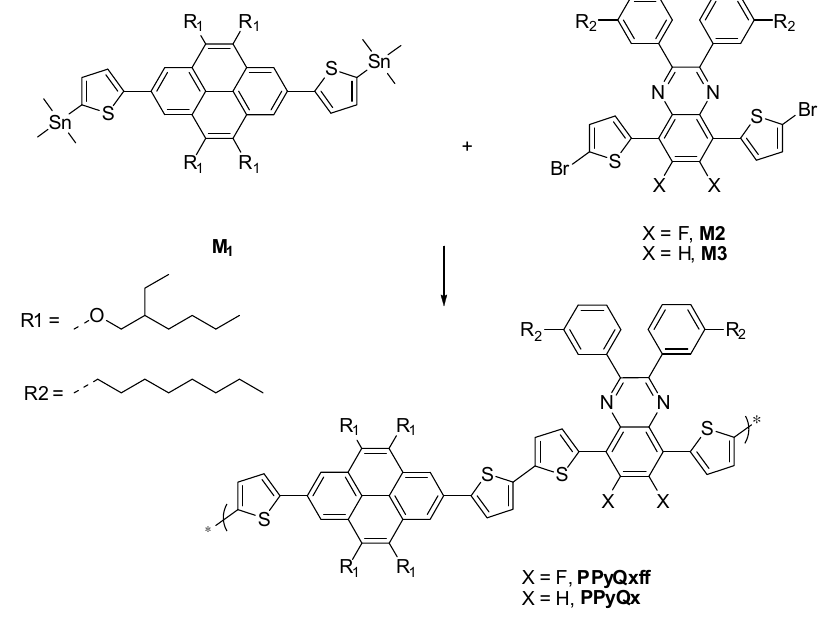
Scheme 1. Synthetic route of PPyQxff and PPyQx.